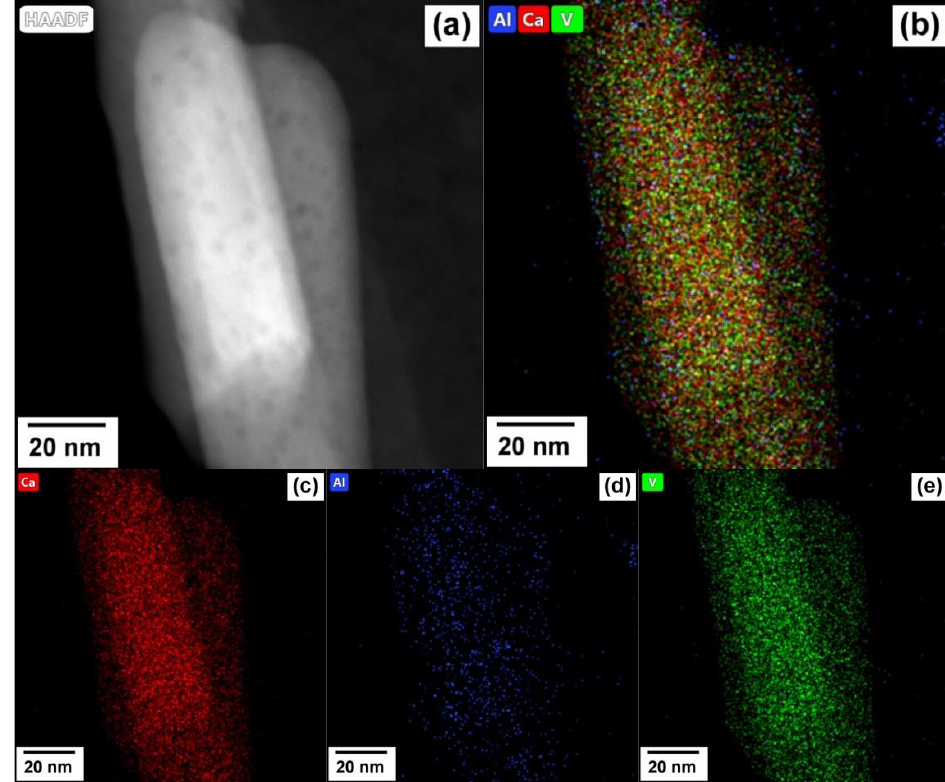
Figure 7. TEM image ( a ) and EDX elemental mapping ( b – e ) of the vanadia-mayenite composite